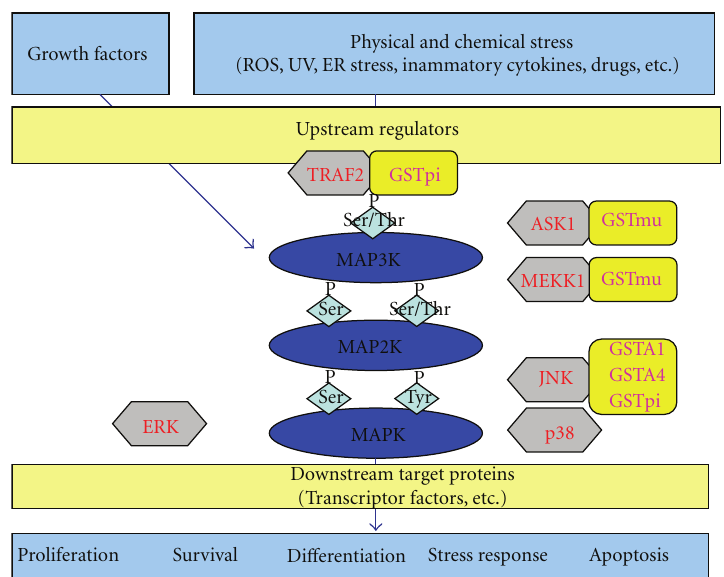
Figure 2: Scheme of the various interactions between GSTs and MAPK implicated in stress-signaling pathway (adapted from [17]). The mitogen-activated protein kinase (MAPK) family is composed of three types of kinases: MAP3K, MAP2K, and MAPK. In mammal, 3 major subgroups of MAPK are found: ERK, JNK, and p38. ERK is activated by proliferation and di ff erentiation stimuli whereas JNK and p38 are preferentially activated by environmental stress. Upstream kinases (MAP3K, MAP2K) initiate activation of MAPK cascade in response to environmental changes and MAPK phosphorylate downstream targets such as transcription factors and generate appropriate biological response. Several GSTs are able to interact with various of these MAPK in nonstress conditions. Environmental stress leads to the disruption of these interactions and the activation of the signaling pathway. ROS: reactive oxygen species; UV: ultraviolet; ER: endoplasmic reticulum; TRAF2; TNF-receptor-associated factor 2; ASK1: apoptosis signal-regulating kinase 1; MEKK1: Mitogen-activated protein kinase kinase kinase 1; JNK: c-Jun N-terminal kinase 1; ERK: extracellular regulated